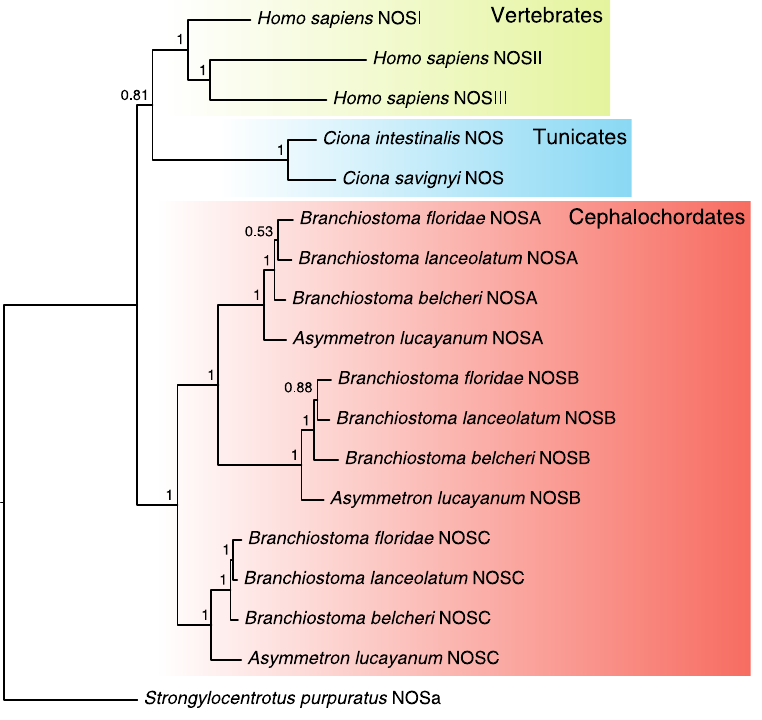
Figure 1. Phylogenetic analyses of NOS proteins in chordates. Bayesian inference-based phylogenetic tree of chordate NOS proteins. Numbers on nodes represent posterior probabilities values. The red box includes cephalochordate proteins, including 3 closely related species of Branchiostoma ( B. lanceolatum , B . floridae and B. belcheri ), plus Asymmetron lucayanum . The blue box contains two ascidian species, Ciona intestinalis and Ciona savignyi . Vertebrate NOS, represented here by Homo sapiens , are highlighted by the yellow box. The NOS protein of the sea urchin Strongylocentrotus purpuratus (Ambulacraria) was used as an